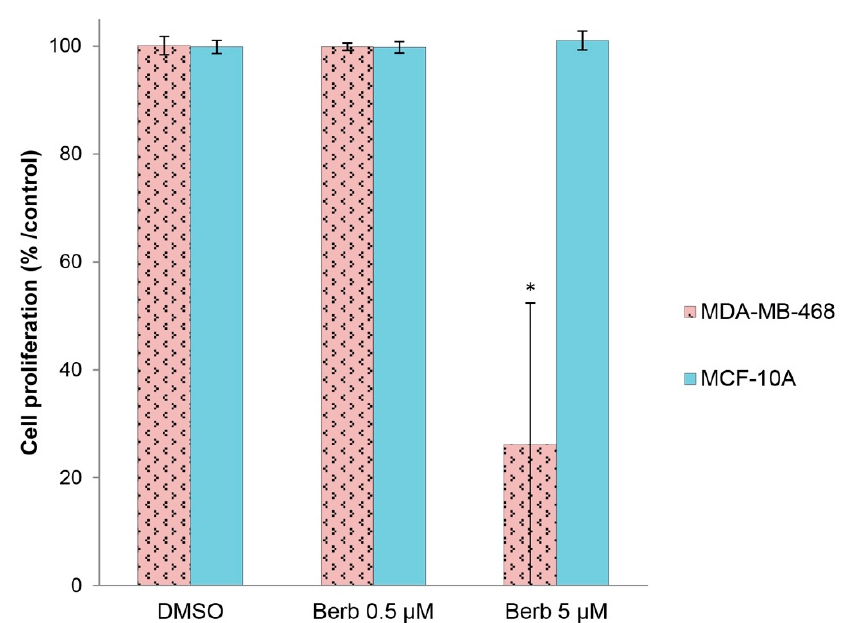
Figure 9. The effect of berberine on the viability of MDA-MB-468 TNBC malignant cells and MCF-10A normal Human epithelial breast cells cultured in matrigel 3D culture. Berberine’s doses: 0.5 and 5 µM. ±SD of three independent experiments, * p < 0.05, ** p < 0.01 and *** p < 0.001 compared to DMSO. Berb—Berberine.